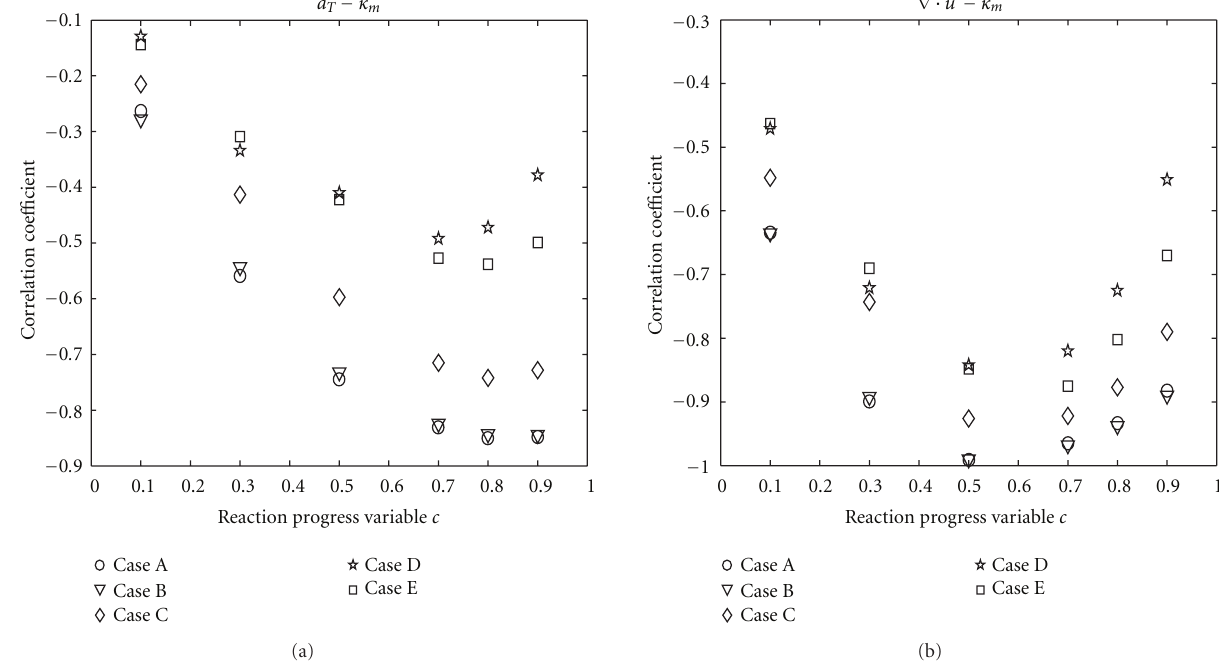
Figure 7: Variation of the correlation coe ffi cients between (a) tangential strain rate a T and curvature κ m and between (b) dilatation rate −→ u ∇ · and curvature κ m on the isosurfaces at c = 0.1 to 0.9 for all cases.